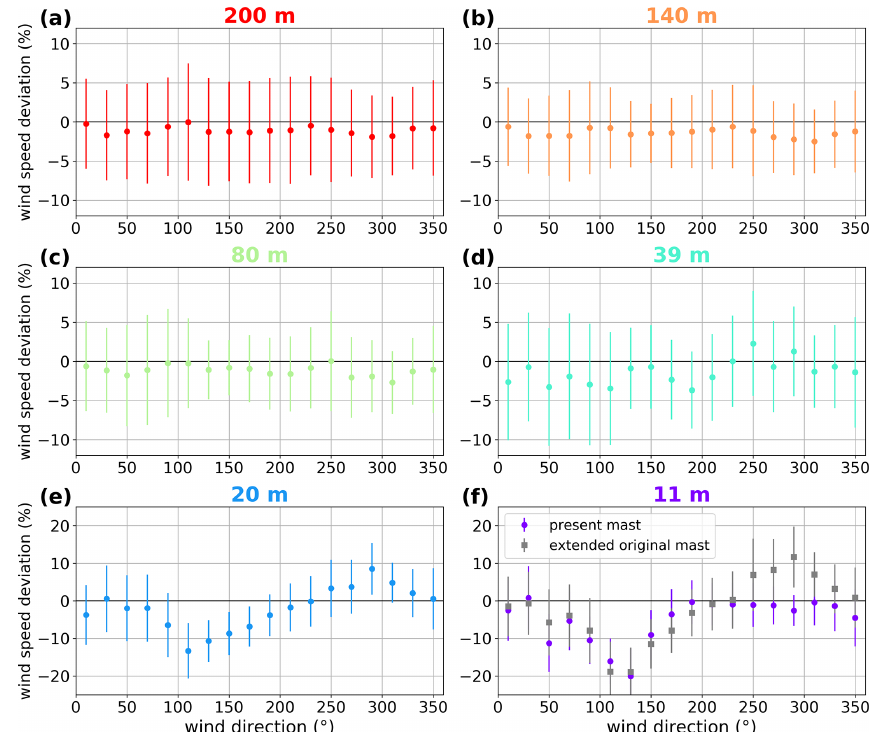
Figure A1. Relative deviation between the wind lidar and the mast wind speed measurements as function of wind direction (at 10m) for the different heights: (a) 200m, (b) 140m, (c) 80m, (d) 39m, (e) 20m and (f) 11m. The data points represent the bin average and standard